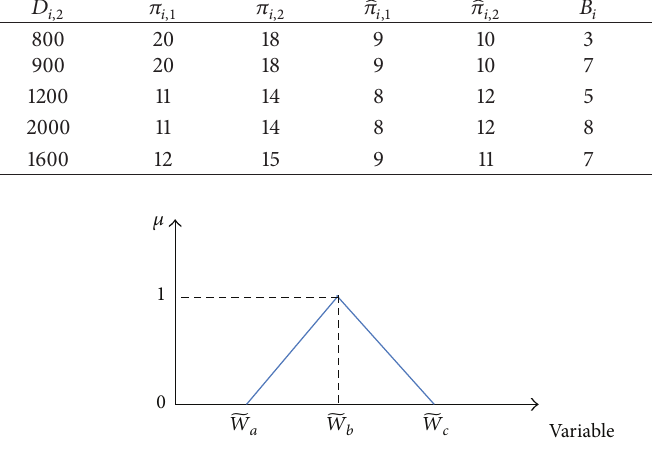
Figure 4: The triangular fuzzy numbers.